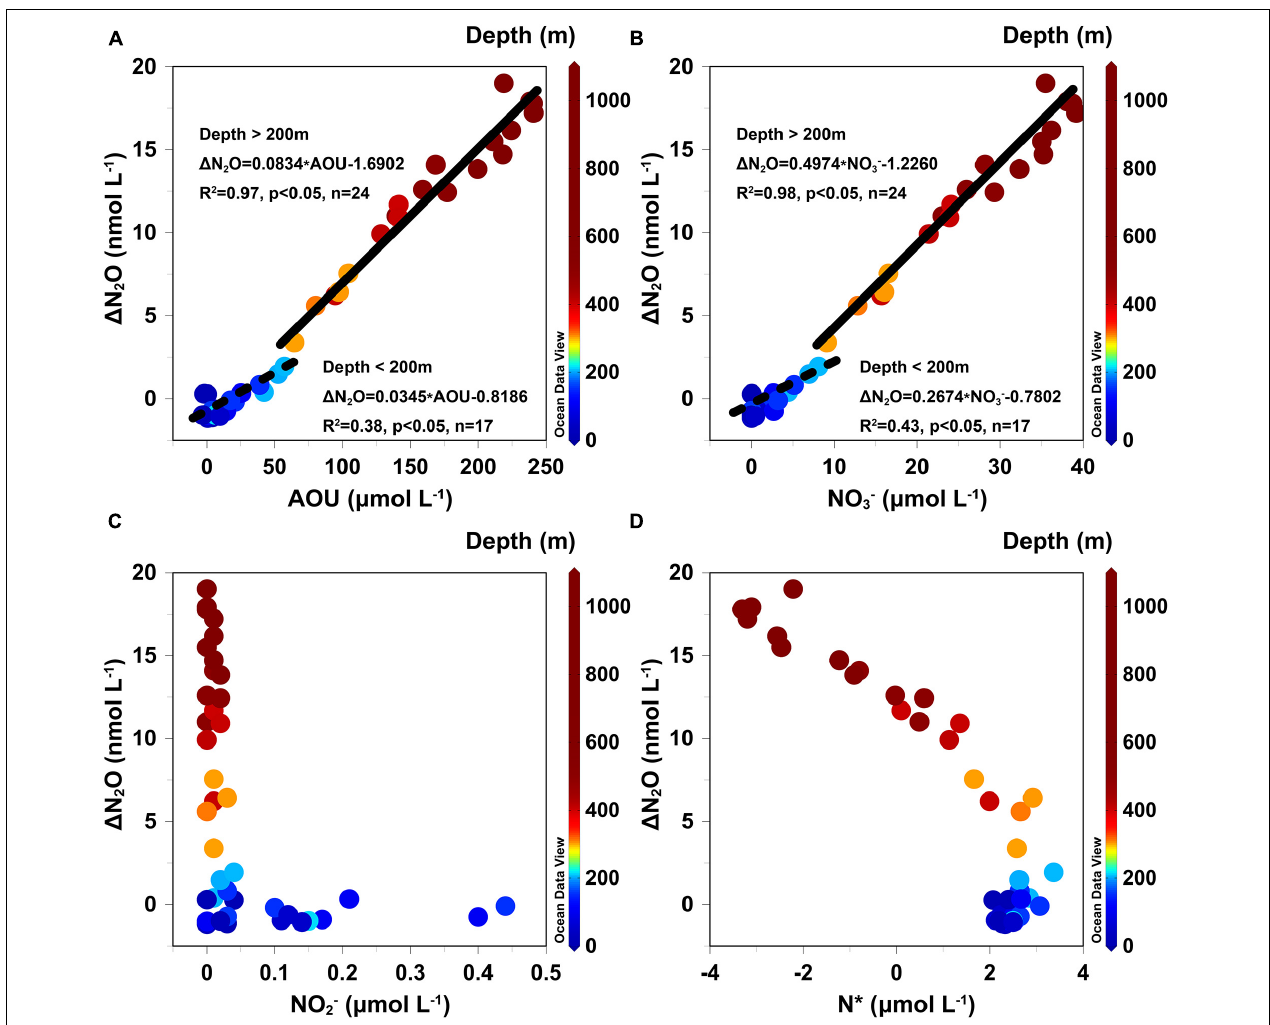
FIGURE 8 | The relationships (A) (cid:49) N 2 O vs. AOU; (B) (cid:49) N 2 O vs. NO 3 − ; (C) (cid:49) N 2 O vs. NO 2 − ; and (D) (cid:49) N 2 O vs. N* in the continental slope water columns. The dashed line and the solid line indicate the linear regression curve for datasets from the upper waters ( < 200 m) and the intermediate and deeper waters ( > 200 m). The color bar shows the water depth